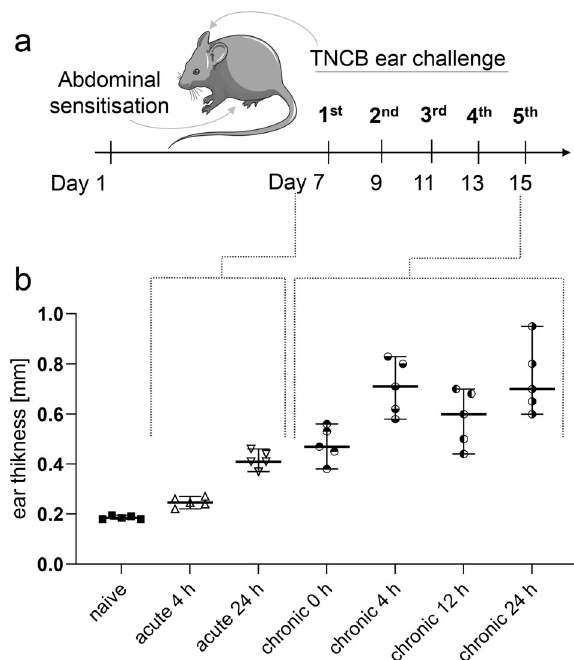
Fig. 1 Experimental setup, course of ear swelling response and metabolite concentration pro fi ling. a Experimental timeline: Sensitisation with 5% trinitrochlorobenzene (TNCB) at the abdomen on Day 1, followed by TNCB ear challenges (1% TNCB) at the right ear on Day 7 (acute DTHR) and repetitive TNCB ear challenges at Days 9, 11, 13 and 15 (chronic DTHR)). b Ear thickness of naive mice and mice with acute (4 h and 24 h after the 1st TNCB challenge) and chronic (0 h – 48 h after the 4th challenge – and 4 h, 12 h and 24 h after the 5 th TNCB challenge) cutaneous DTHR ( n = 4